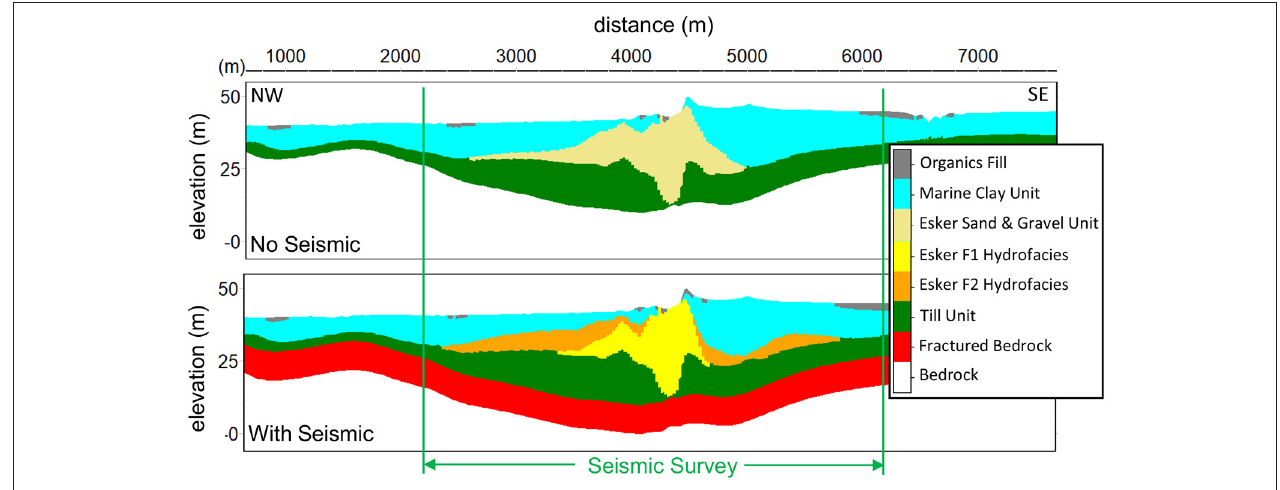
FIGURE 8 | Northwest to southeast cross-sections of the 3D conceptual model without and considering the seismic data and well